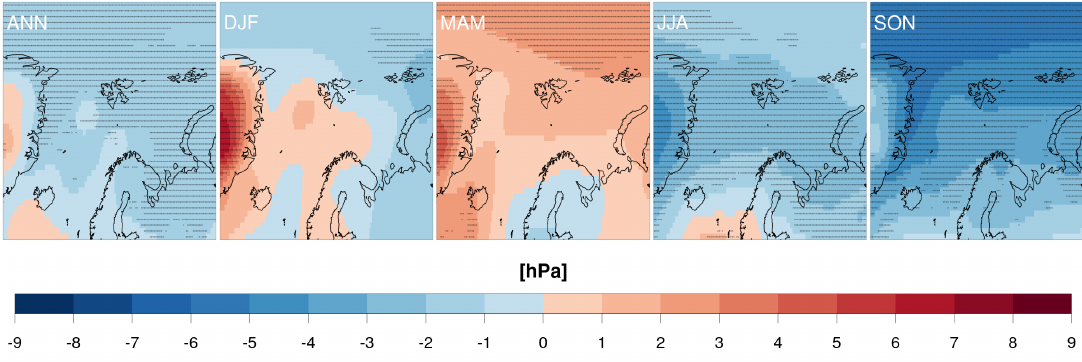
Figure 7. Projected changes from 1971–2000 to 2071–2100 in the mean annual and seasonal sea level pressure in the MPI-ESM-LR climate simulation. Statistically significant changes are marked with dots. The labels in the top left corners refer to the annual mean (ANN) or the months of the specific season of the year.